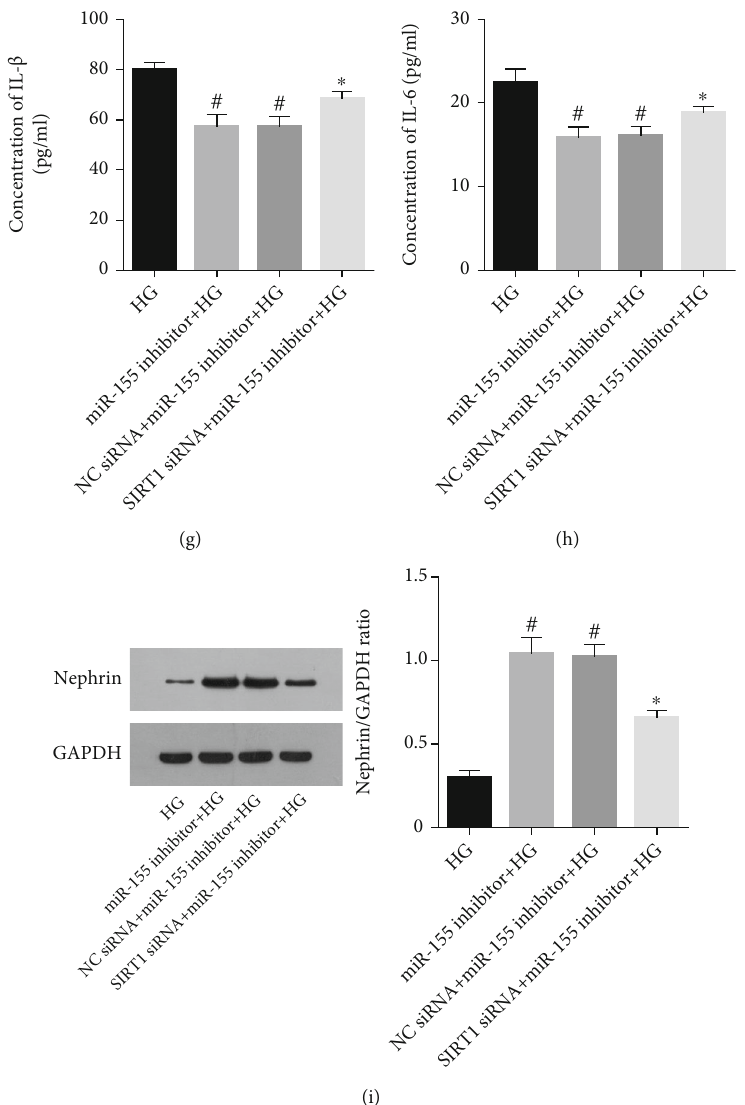
Figure 4: The e ff ects of miR-155 silencing on podocyte in fl ammation was reversed by SIRT1 downregulation. (a, b) SIRT1 expression in podocytes transfected with the miR-155 mimic or inhibitor under high glucose conditions was evaluated using real-time PCR and Western blotting analysis. # Compared with control group, P < 0 : 05 ; ∗ Compared with HG (high glucose) group, P < 0 : 05 . (c, d) The expression of SIRT1 in podocytes transfected with the miR-155 inhibitor and SIRT1 siRNA under high glucose conditions was assessed using real-time PCR and Western blotting analysis. # Compared with HG (high glucose) group, P < 0 : 05 ; ∗ Compared with miR-155 inhibitor + HG group, P < 0 : 05 , the same below. (e – h) In fl ammatory cytokine expressions (MCP-1, TNF- α , IL-1 β , and IL-6) in podocytes transfected with the miR-155 inhibitor and SIRT1 siRNA under high glucose conditions was determined using ELISA. (i) Nephrin expression in podocytes cotransfected with the miR-155 inhibitor and SIRT1 siRNA under high glucose conditions was quanti fi ed using Western blotting